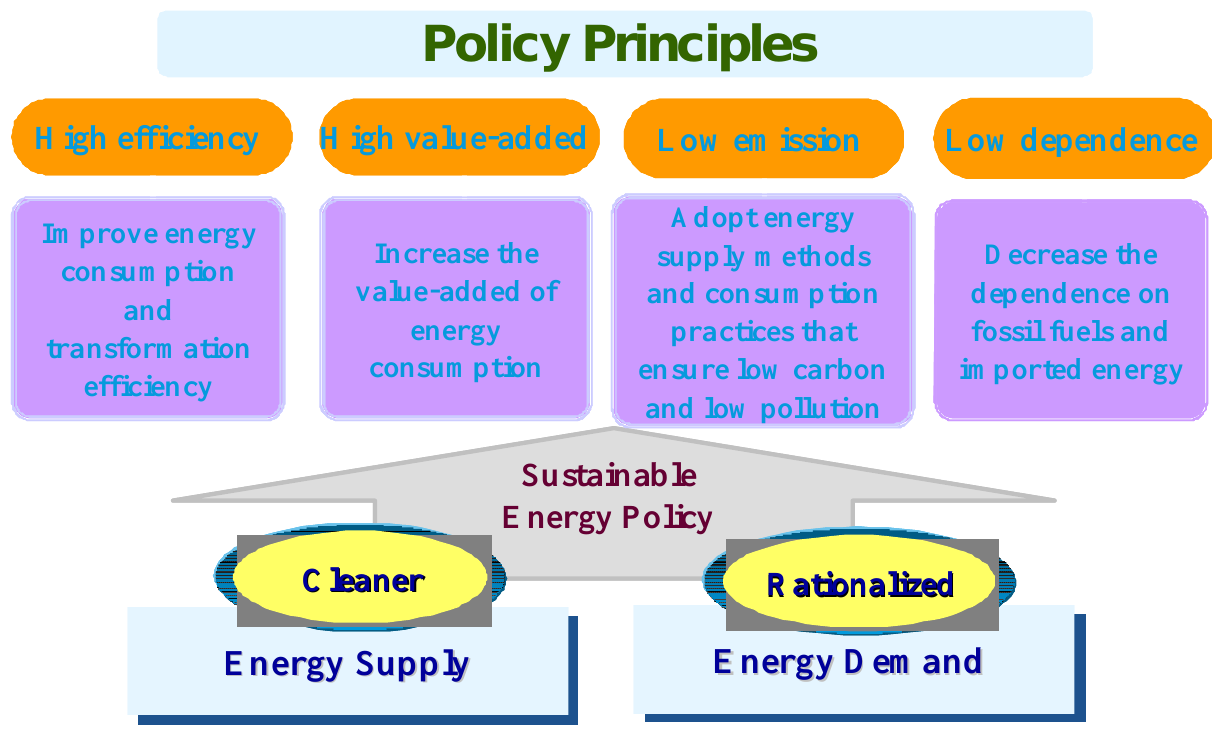
Figure 7. The policy principles and strategies of Taiwan’s sustainable energy policies